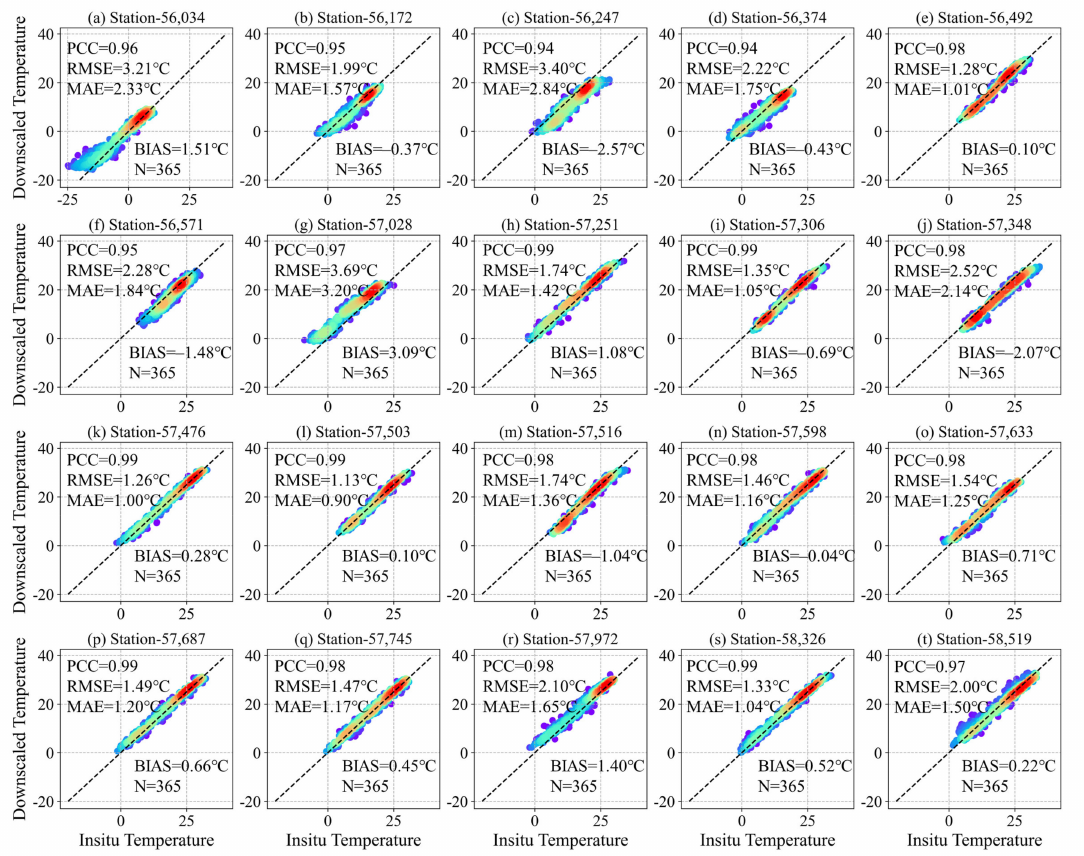
Figure 5. The scatter density plots and statistical metrics for 20 validation stations. The x and y axes represent in-situ ground measurements and downscaled temperature, respectively. The red color represents dense concentration of scatters. N means the number of observations for